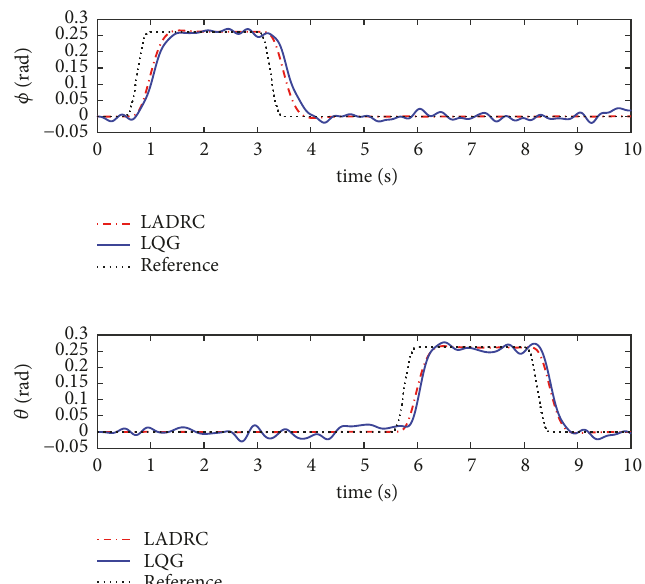
Figure 9: Attitude responses of both controllers with wind disturbance.